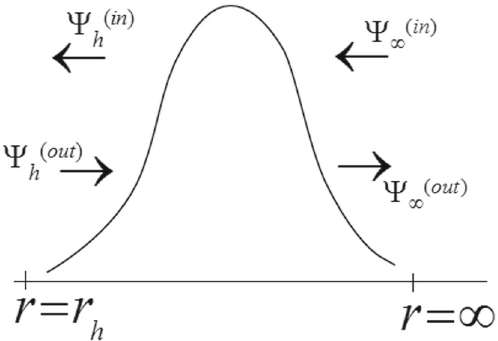
Fig. 1 Illustrationofparticle’sfluxesinthenear-horizonofblackholes